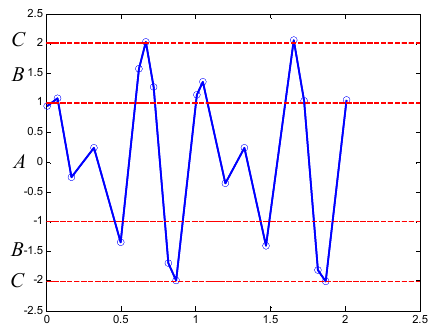
Figure 5. Symbolization results of simulating signal based on 3 σ criterion.